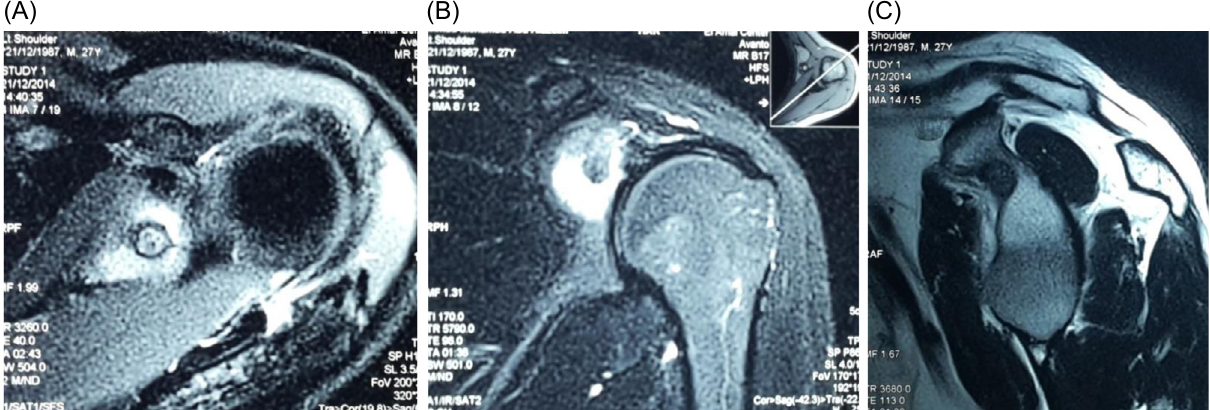
Figure 1. (A and B) T2-weighted MRI images showing high signal intensity within the glenoid around the lesion with low signal, (C) T1-weighted sagittal image reveals a low signal lesion at the base of the corocoid.